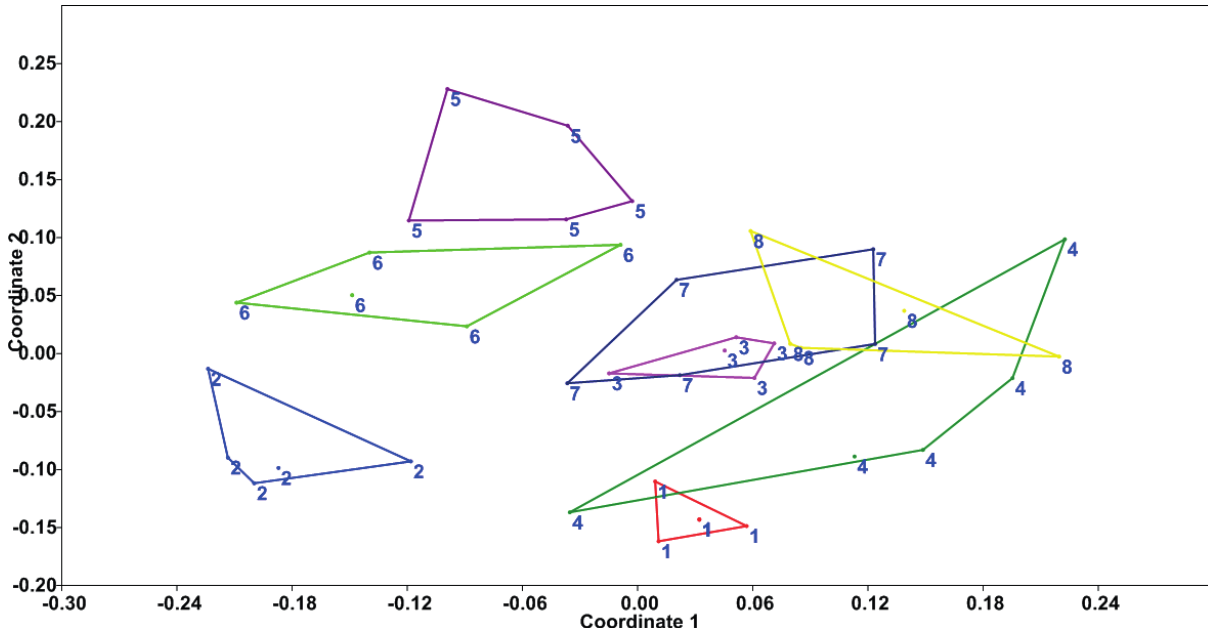
Figure 2. MDS plot of populations in Pistacia khinjuk based on IRAP data. (Population numbers are according to Table 1).